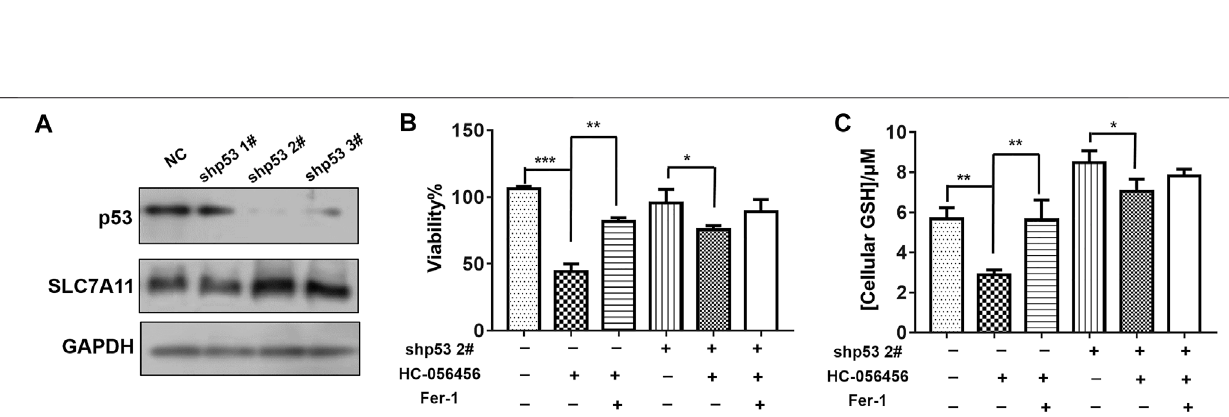
FIGURE7| HC-056456inducedferroptosisinap53-dependentmanner.Thep53-knockdownMGC-803cellwasconstructed (A) Thelevelsofp53andSLC7A11 were detected by Western Blot (B) The viability of cells was calculated (C) The level of cellular GSH was carried out. * p < 0.05, ** p < 0.01, *** p < 0.001 versus control group.